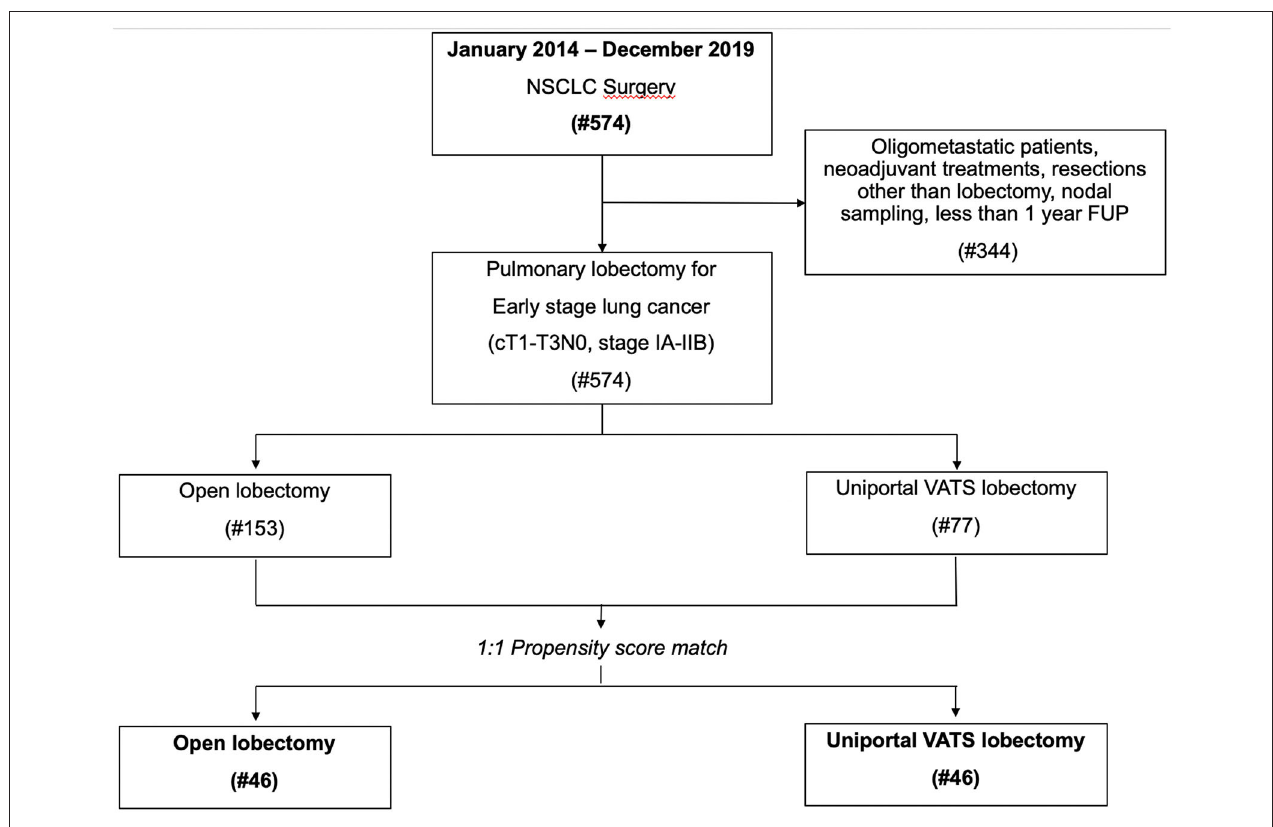
FIGURE 1 | Study flow-chart with reasons for patient exclusion.